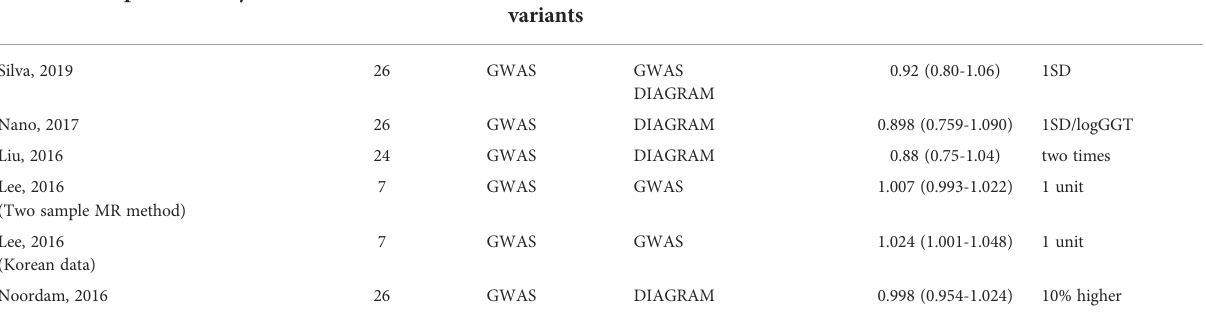
TABLE 4 Summary of the Mendelian randomization study verifying the causal relationship of GGT on T2DM. Lead author, publication